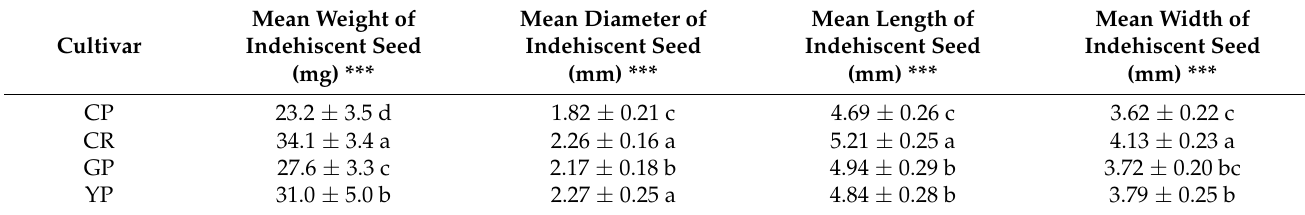
Table 2. Characteristics of indehiscent seeds depending on the cultivar of P. ginseng. Mean Weight Cultivar